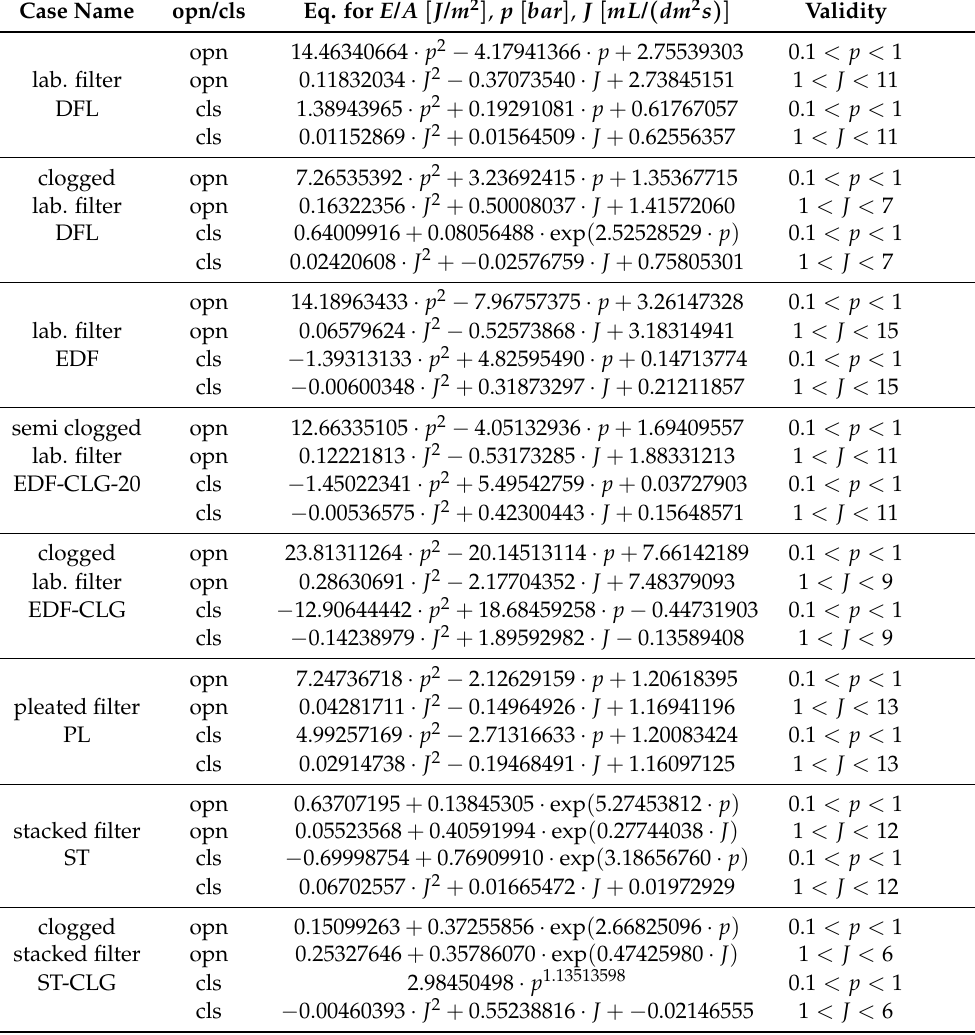
Table 5. Models for specific energy intake during valve opening and closing. Experiments based on which the models were developed were performed with distilled water and 2-1 valve